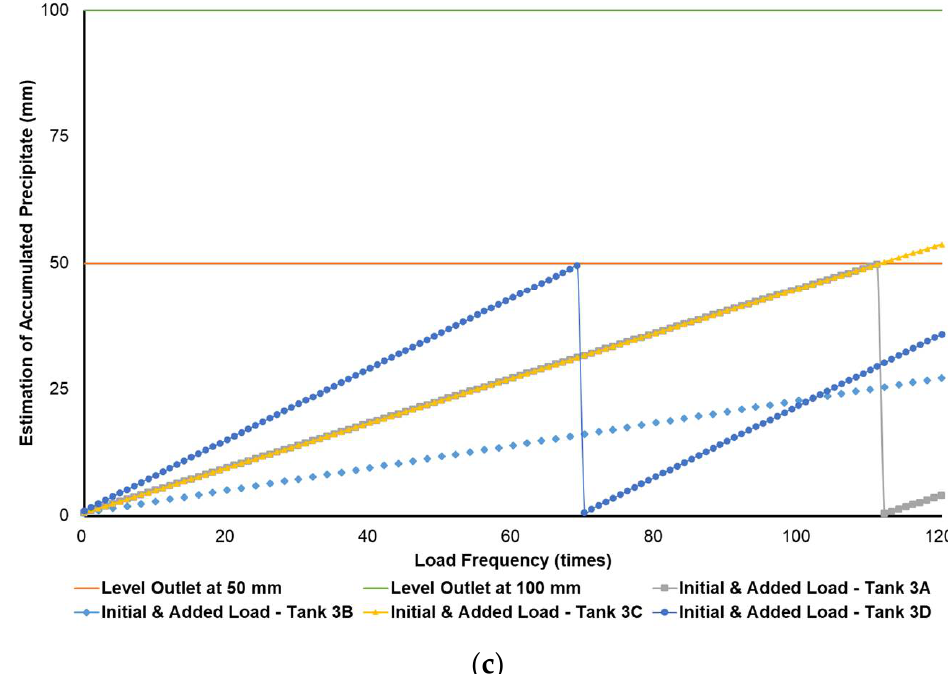
Figure 3. Schedule simulation for sludge removal from the storage tank of B20 fuel blended from B100 with monoglyceride content of 0.437%-mass. The tank volume is ( a ) 50, ( b ) 100, and ( c ) 200 m 3 . Figure 4a–c simulates the removal schedule of sludge accumulated from B20 fuel using B100 with a monoglyceride content of 0.623%-mass in different tank storage volumes.